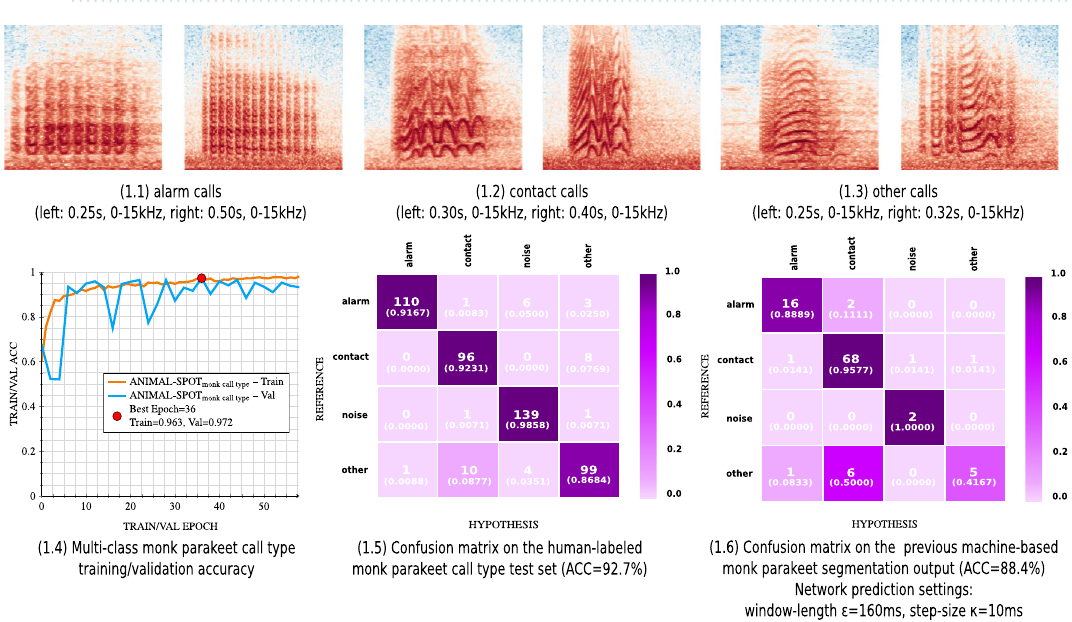
Figure 6. Multi-class call type classification results, visualizing spectrogram examples of alarm, contact, and other call types ( 1.1 – 1.3 ), multi-class training/validation accuracy ( 1.4 ), confusion matrix regarding the unseen human-labeled test data ( 1.5 ), as well as confusion matrix concerning previous machine-based monk parakeet detection ( 1.6 ) (created via Inkscape 39 , Version